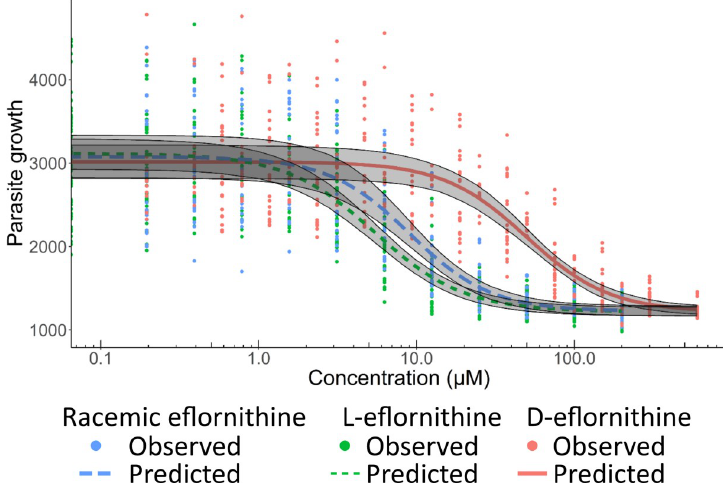
Fig 2. The overall antitrypanosomal in vitro activity was elicited by the more active L-eflornithine enantiomer. Antitrypanosomal activity for racemic eflornithine (blue), L-eflornithine (green) and D-eflornithine (red) against three T . b . gambiense strains collectively. Parasite growth values are shown as relative fluorescence in the AlamarBlue serial drug dilution assay. Dots represent observed experimental data, lines the model predictions and grey areas the 5 th to 95 th percentiles of the model prediction central